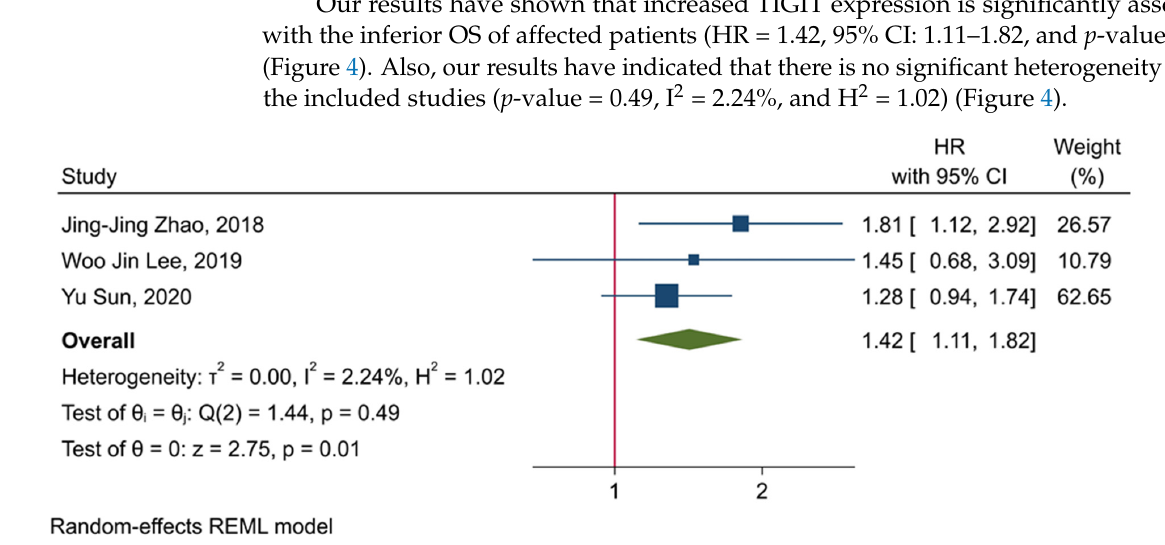
Figure 3. Forest plot for evaluating the association between the expression of TIGIT and PD-1.